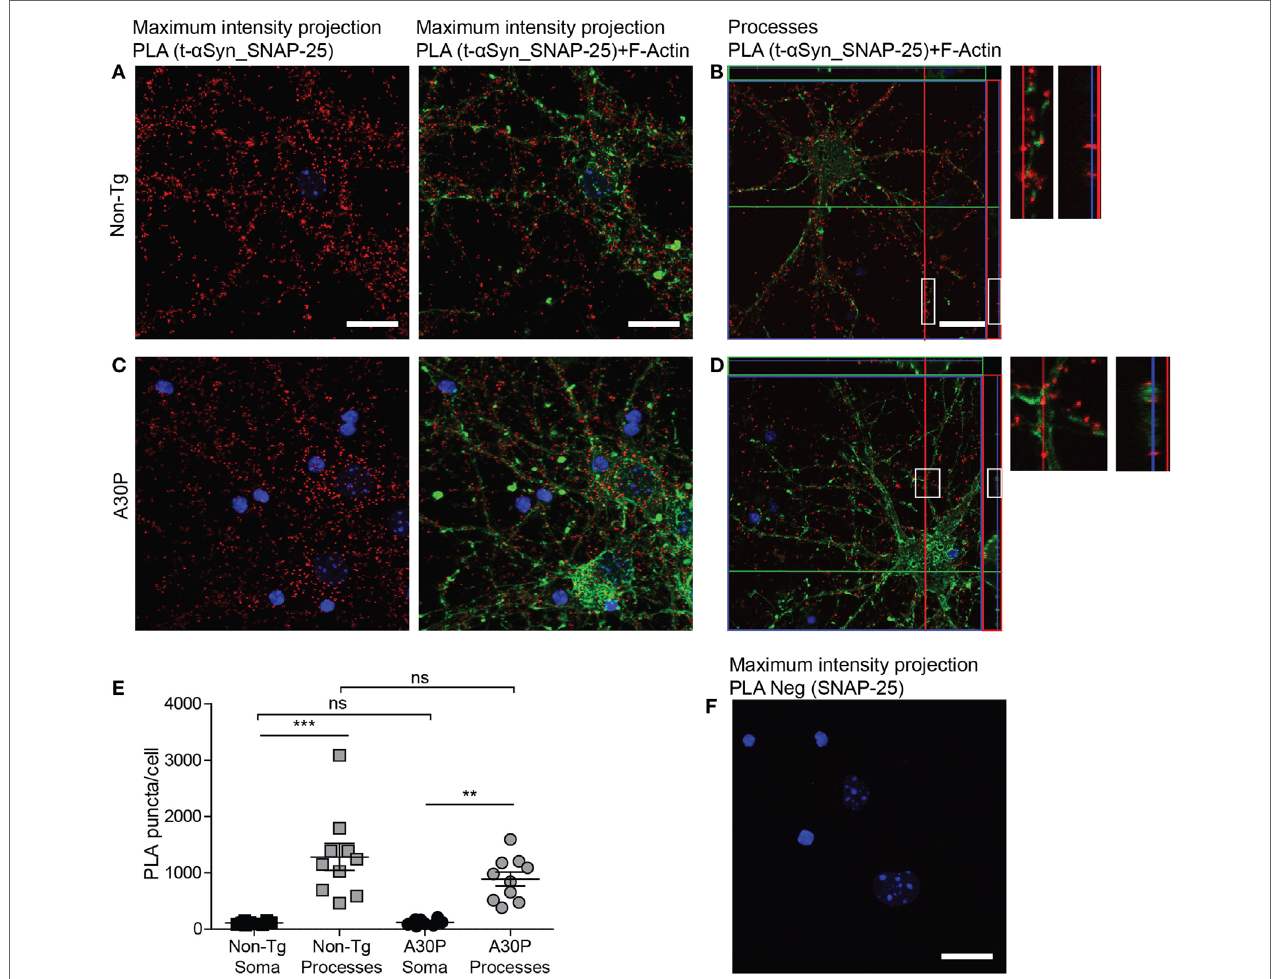
FigUre 4 | Representative confocal images of in situ proximity ligation assay (PLA) between alpha-synuclein ( α Syn) (mAb1338) and SNAP-25 (red) in non-tg (a,B) and A30P (c,D) cortical primary neurons. Maximum intensity projections of a confocal z-stack including a whole cell were performed to observe the maximum amount of PLA puncta (a,c) . Cross section of the processes allows visualization of the PLA puncta in an orthogonal view [ (B,D) , inlet], scale bar 20 µm. F-actin stained by phalloidin-FITC (green) and DAPI (blue). Quantification of amount of PLA puncta per cell in the soma and processes. One-way ANOVA followed by Bonferroni post hoc test, non-significant (ns), *** P < 0.001. Error bars represent the SEM (e) . Negative control PLA with SNAP-25 antibody only (F) . Scale bar 20